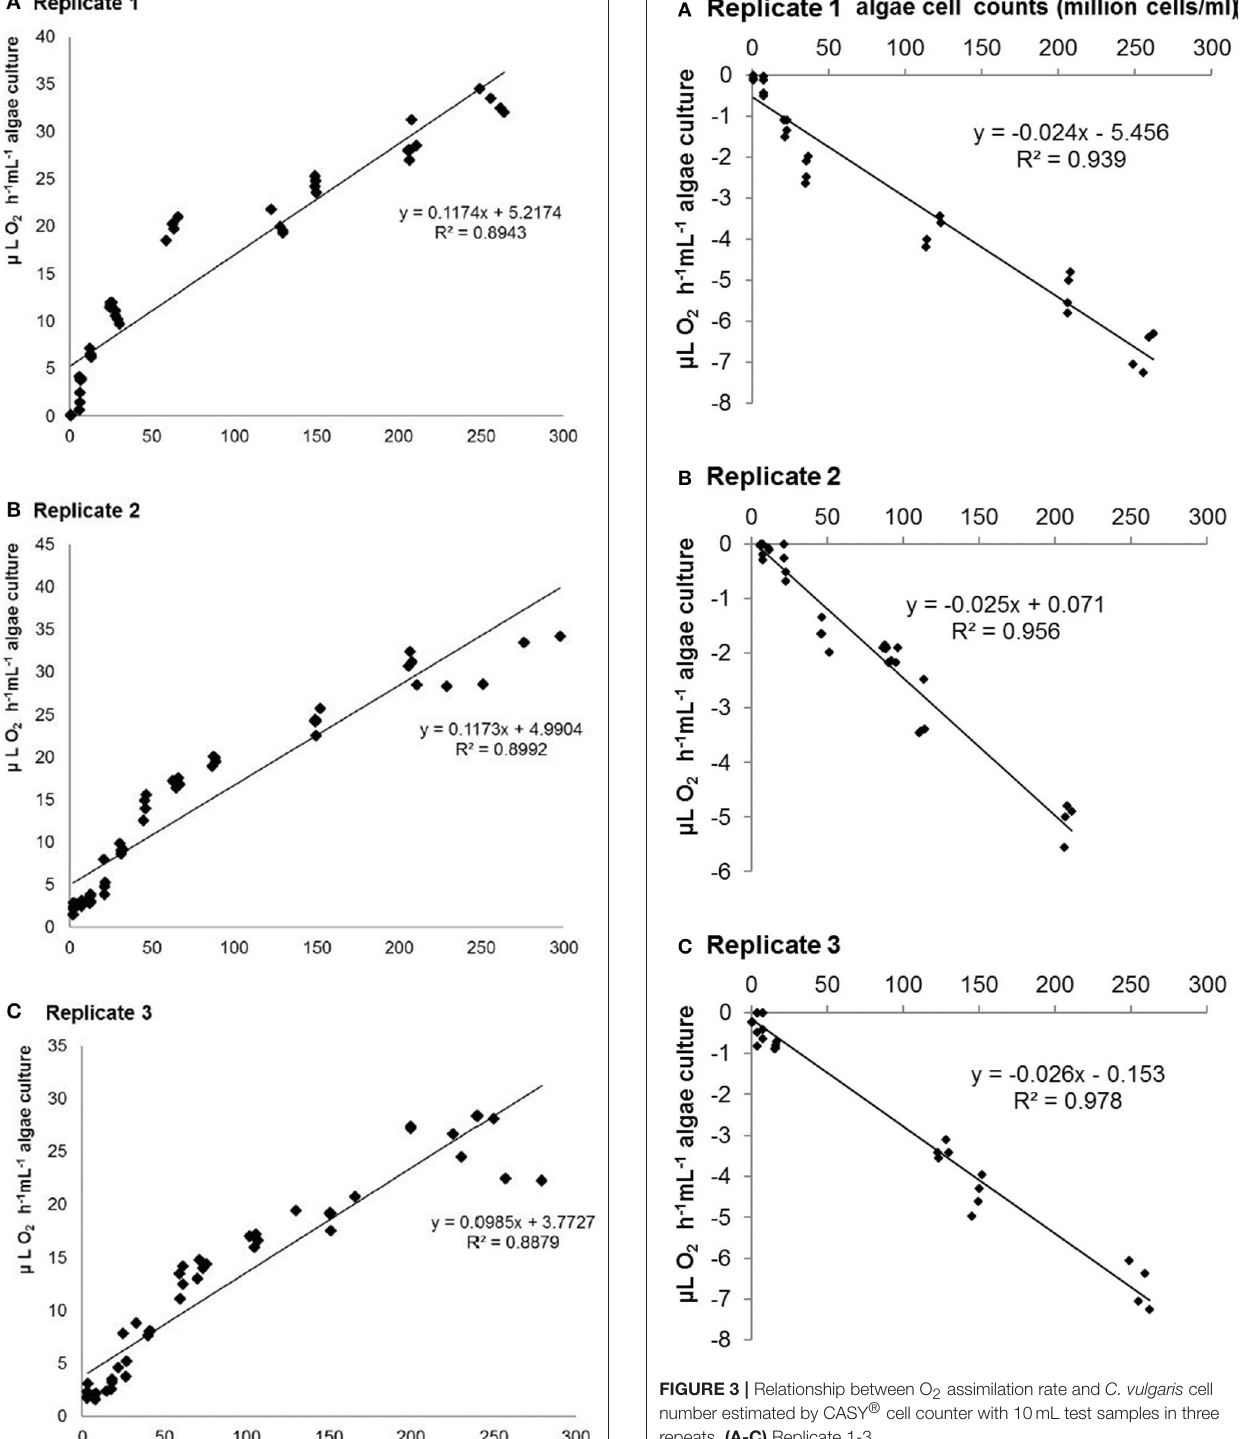
samples (10 g soil mixed with 0.5 mL 10% glucose and distilled water) were transferred into 30 mL glass flasks and closed with air tight rubber lids. The experiments were performed in a